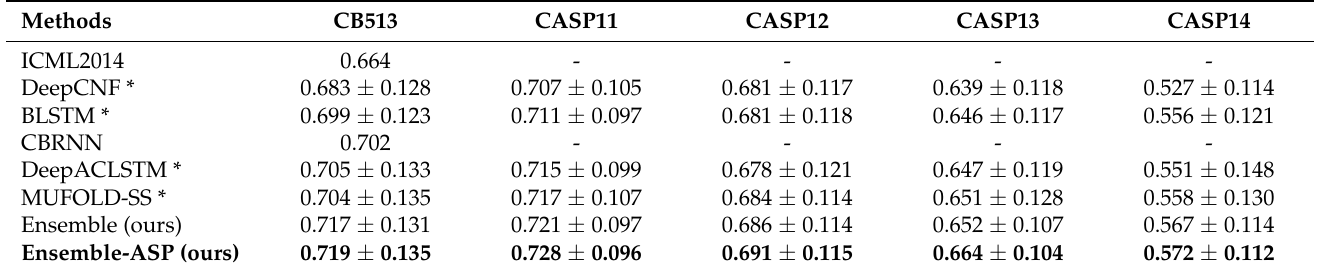
Table 6. The comparison between the Q8 results (the mean and standard deviation measured over the proteins within each test set) of our method and the results of state-of-the-art